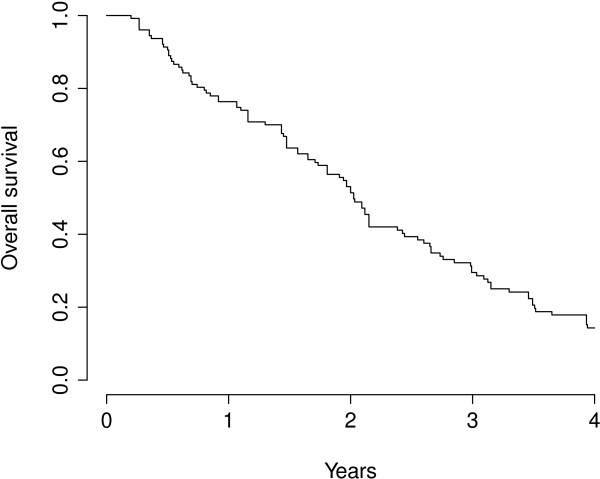
Kaplan-Meier overall survival curve for all patients.